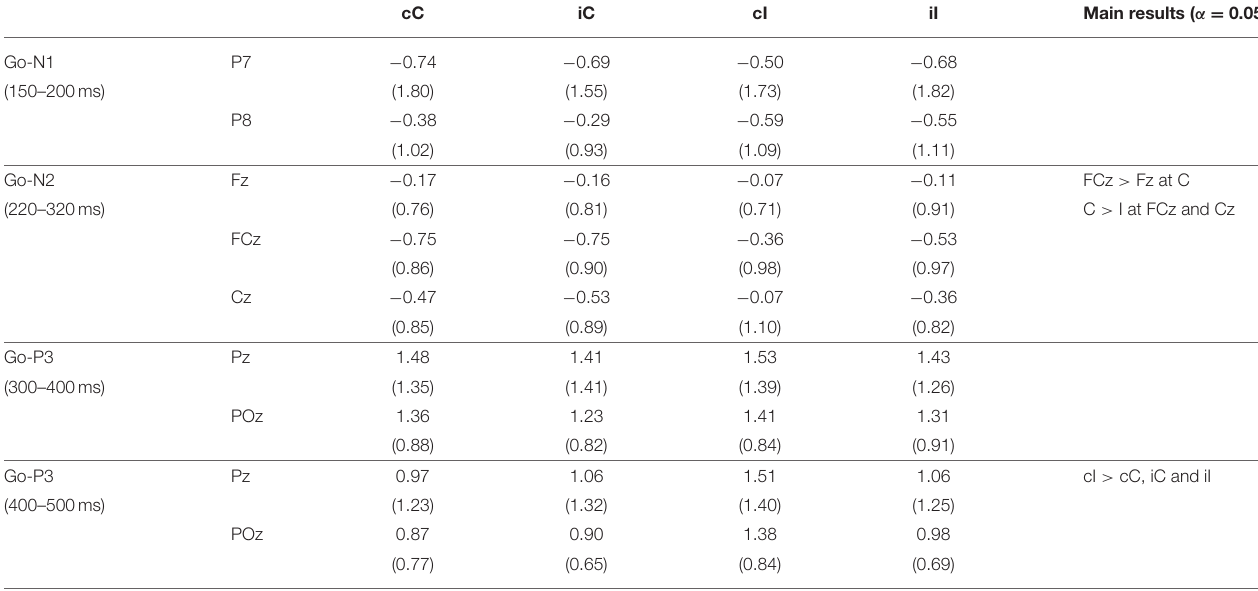
TABLE 1 | Means (SD) of event-related potential (ERP) amplitudes for Go-stimuli. cC iC cI iI Main results ( α = 0.05)